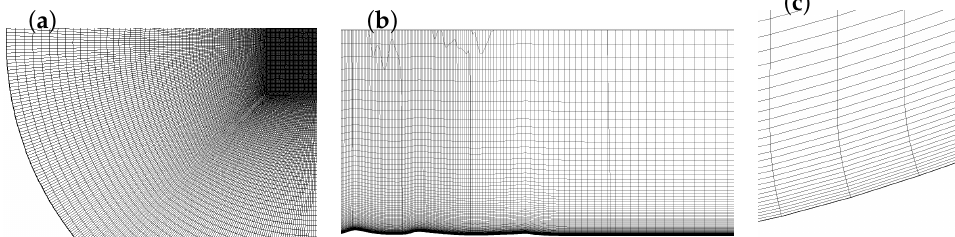
Figure 3. Snapshots from the micro-scale simulation grid. ( a ) top view on the southwestern section of the domain, ( b ) sideview on the central eastern part of the domain and ( c ) closeup on the left hill in ( b